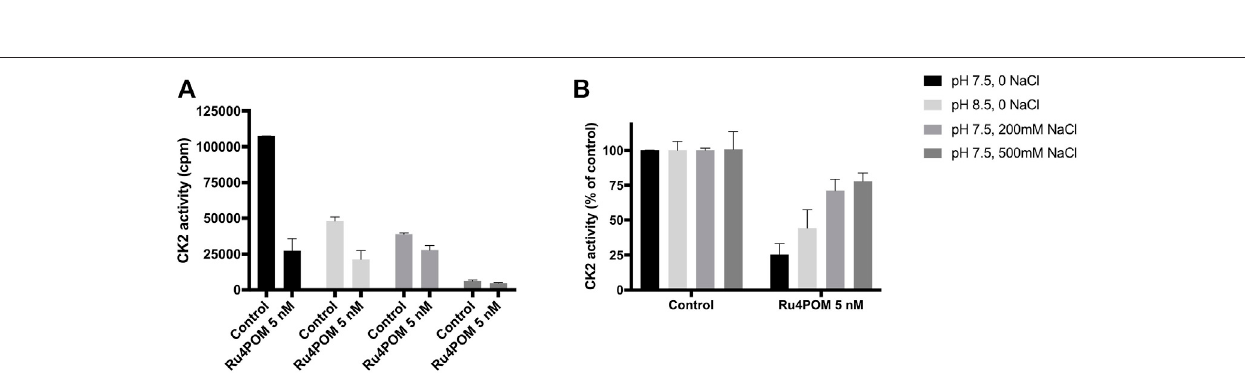
FIGURE 3 | Effect of pH and ionic strength. CK2 activity was measured by radioactive phosphorylation assays towards CK2-tide peptide, in the absence or presence of 5 nM Ru 4 POM, at different conditions of pH and NaCl concentration, as indicated. Radioactivity was detected by scintillation counting (cpm) (A) . In (B) , 100% activity was assigned to each control, measured in the absence of Ru 4 POM. Mean values ± SEM of at least two independent experiments are reported.